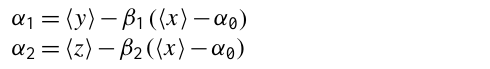
Finally the coefficients α 1 and α 2 are estimated